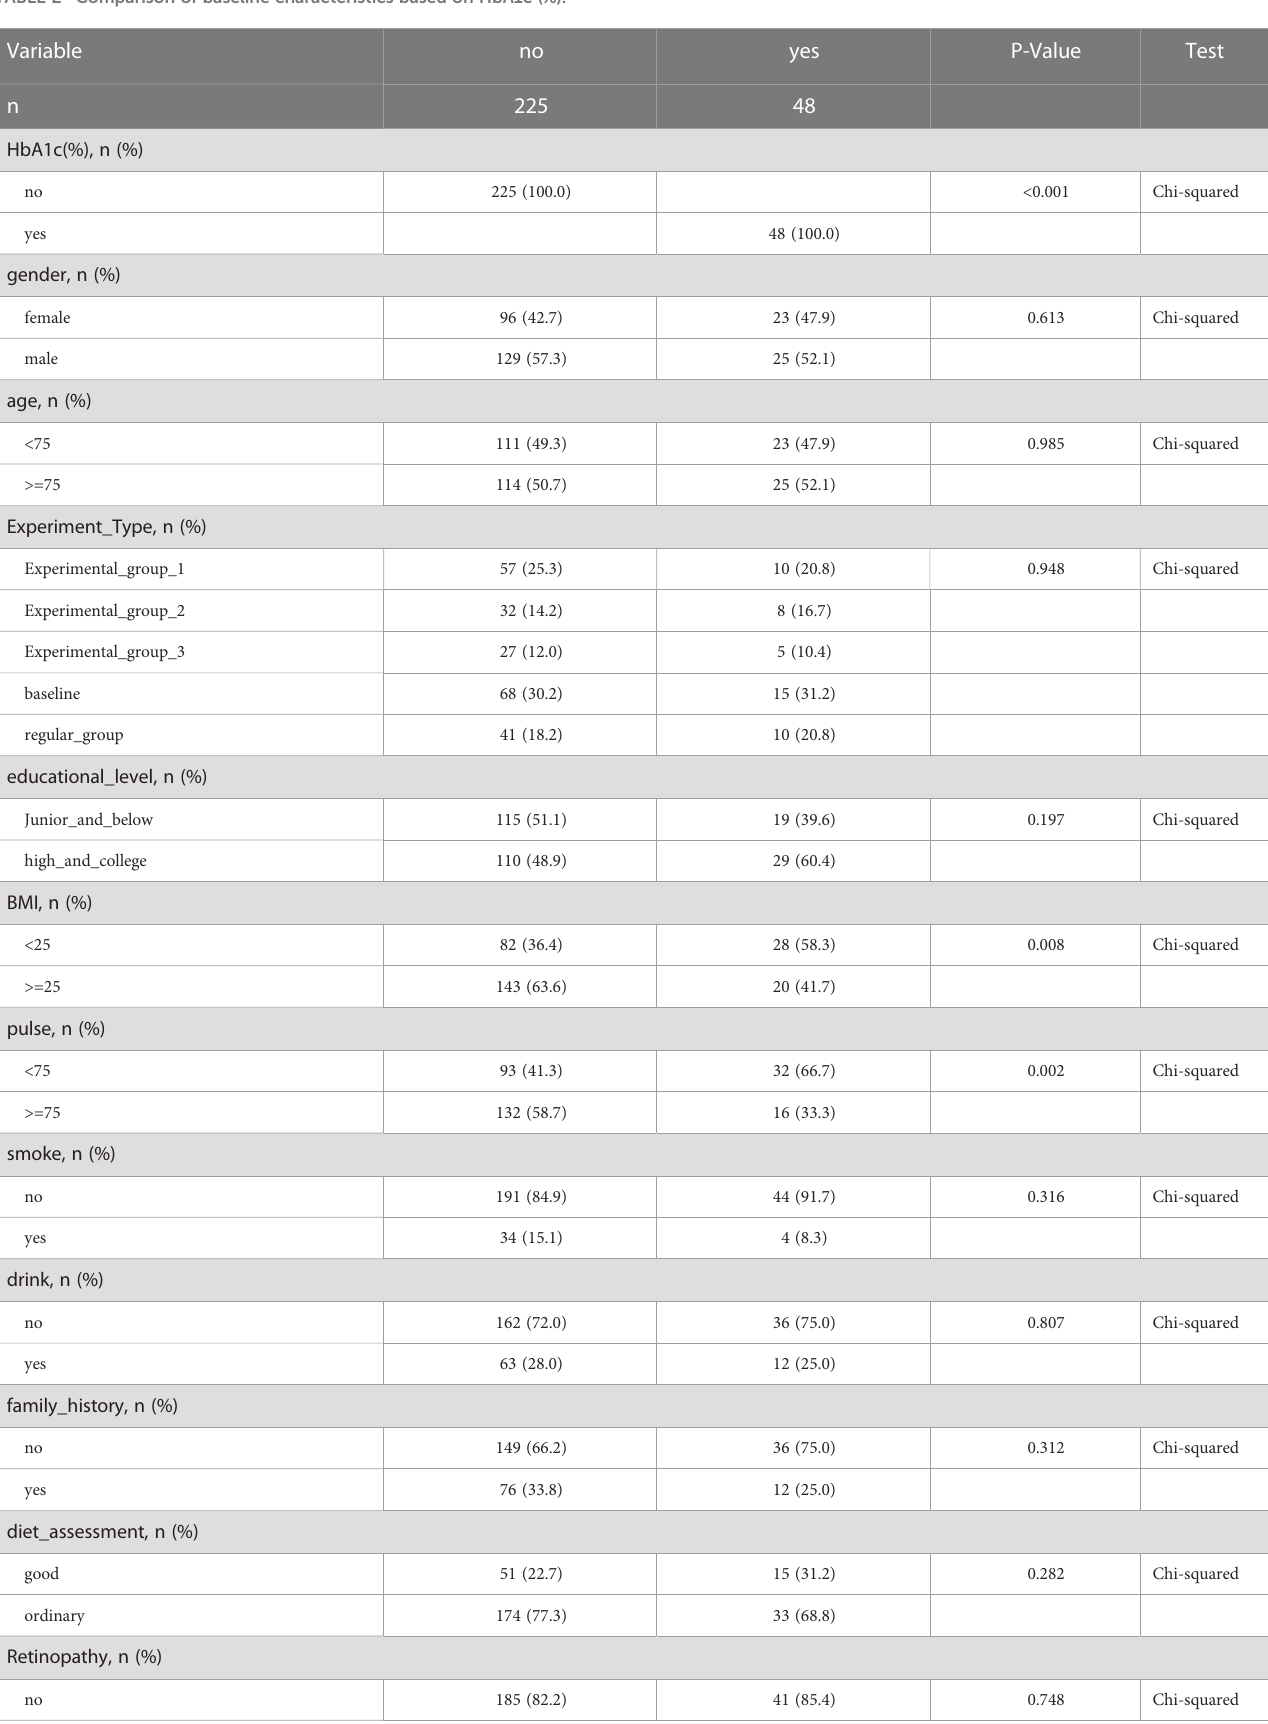
TABLE 2 Comparison of baseline characteristics based on HbA1c